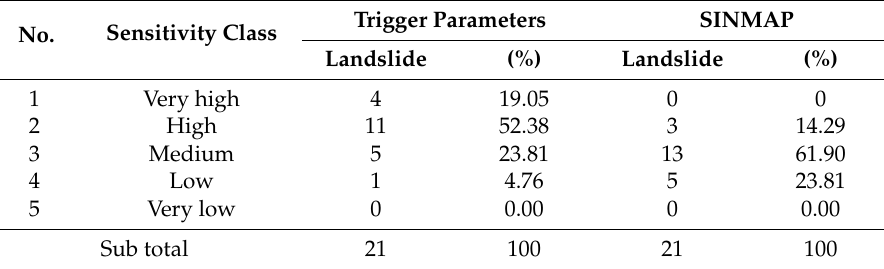
Table 6. Validation of the number of landslide events.